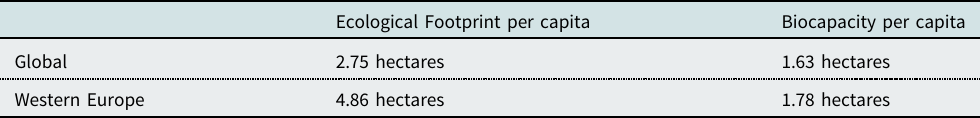
Table 1: The Ecological Footprint and Biocapacity of Western Europe and the World Compared Ecological Footprint per